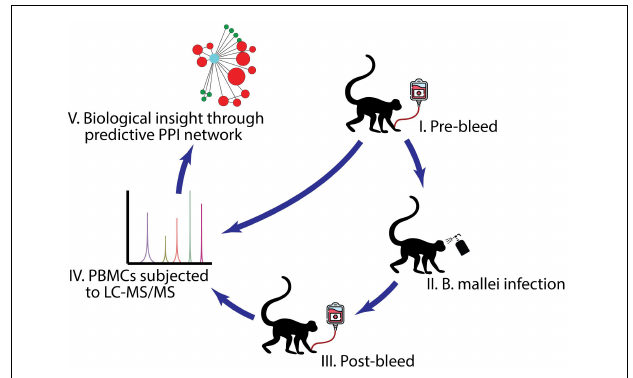
FIGURE 1 | A schematic diagram of the experimental design. (I) PBMC samples were collected from rhesus macaques ( n = 6), African green monkeys ( n = 4), and cynomolgus macaques ( n = 5) before B. mallei infection. (II) NHPs were infected with B. mallei at a CFU = 2.3 × 10 7 via the aerosol route. (III) PBMC samples were collected from rhesus macaques, African green monkeys and cynomolgus macaques either at the time of euthanasia based on clinical score or those that survived till the end of study design. (IV) PBMCs purified from the surviving NHPs were subjected for LC-MS/MS analyses and the abundance of proteins within biological samples were identified. (V) A host- B. mallei virulence factor protein-protein interaction network was constructed. Icons- Monkey, spray bottle and transfusion bag were made by Freepik.